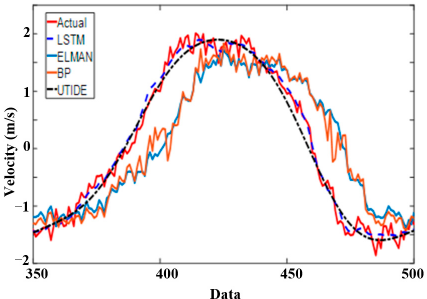
Figure 12. Enlarged figure of the comparison results in Figure 11.